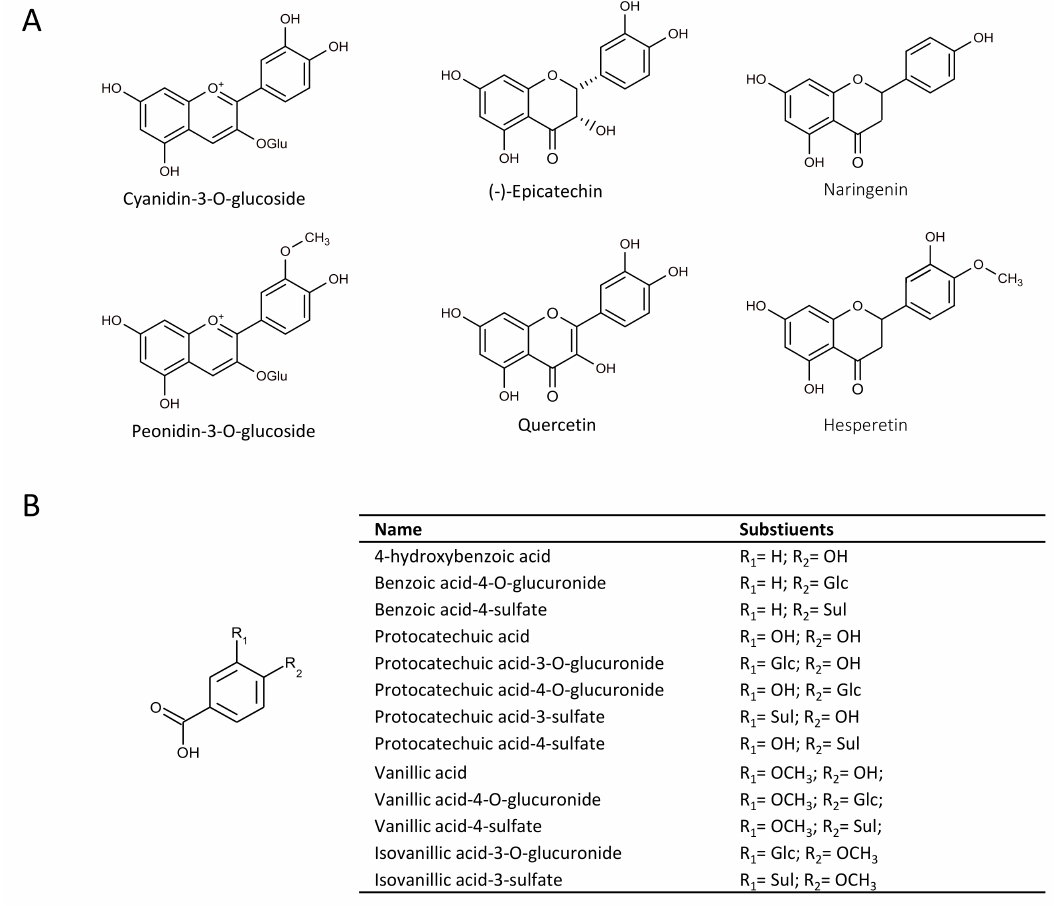
Figure 1. Structures of ( A ) flavonoids and ( B ) metabolites included in treatments. OH, hydroxyl; Glc, oxygen-linked-glucuronide; OGlu, oxygen-linked glycoside; Sul, sulfate; OCH 3 , oxygen-linked methyl